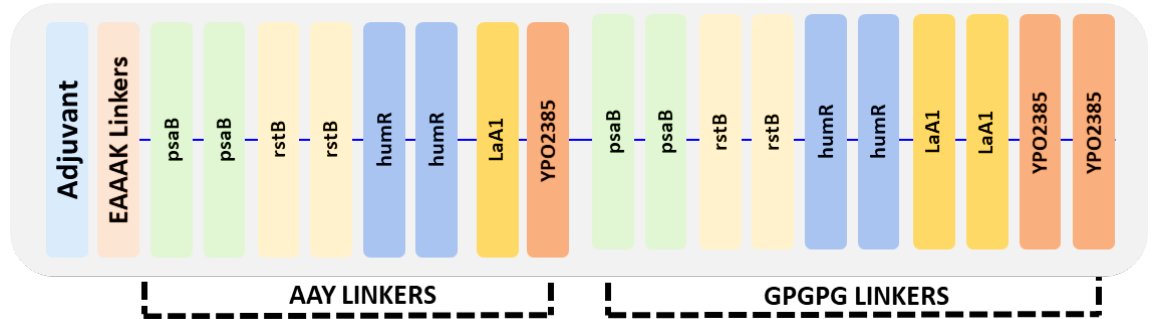
Figure 3. Arrangement of the final vaccine construct design comprising CTL and HTL epitopes using three different linkers: AAY, GPGPG, and EAAAK.